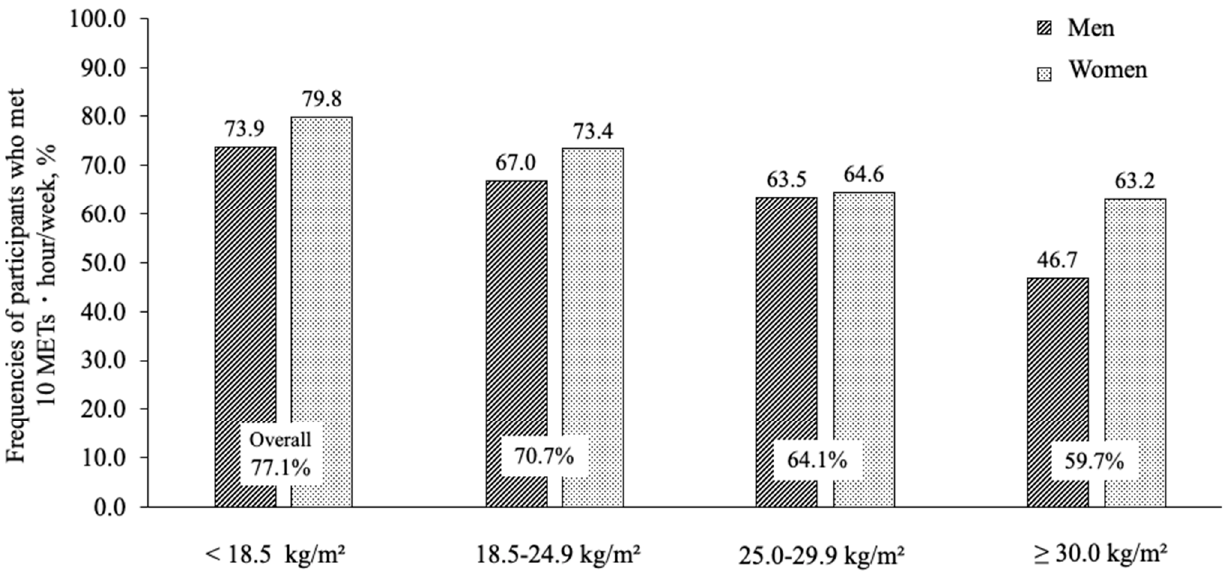
Figure 2. Percentage of participants who met 10 METs · hour/week guideline only considering MVPA by sex and BMI.